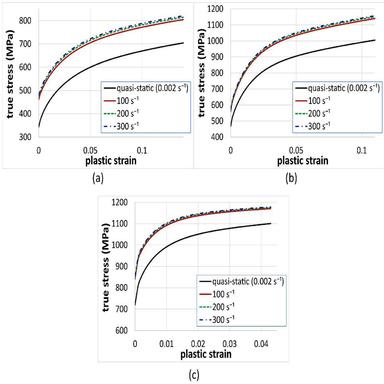
The identified stress-strain curves at the chosen strain rates (a) DP590 (b) DP780 (c) DP980.